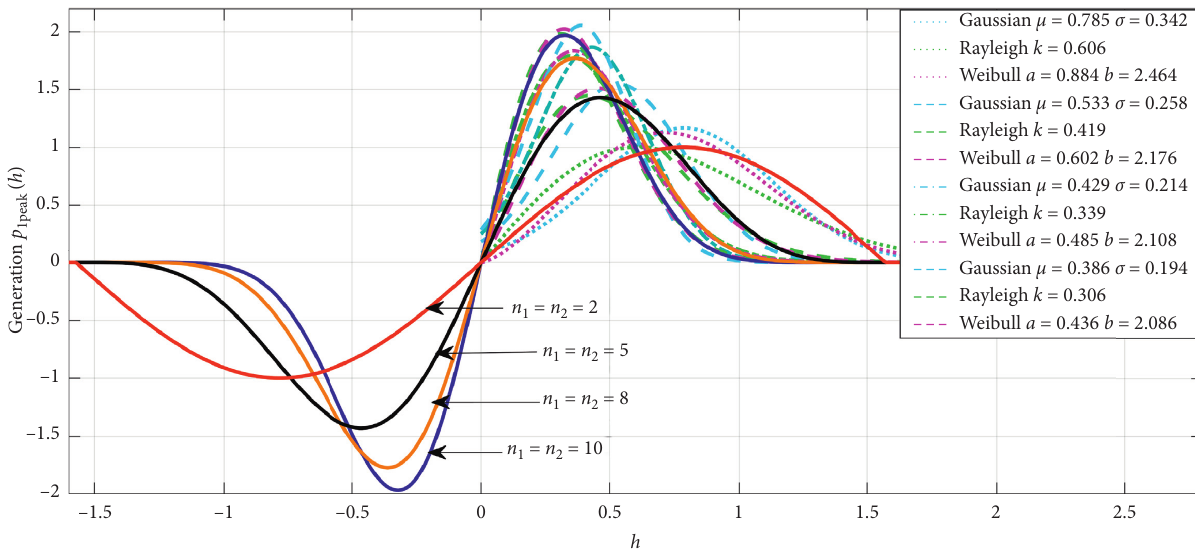
Figure 18: Generalized peak PDFs of ATNPS for various values of n